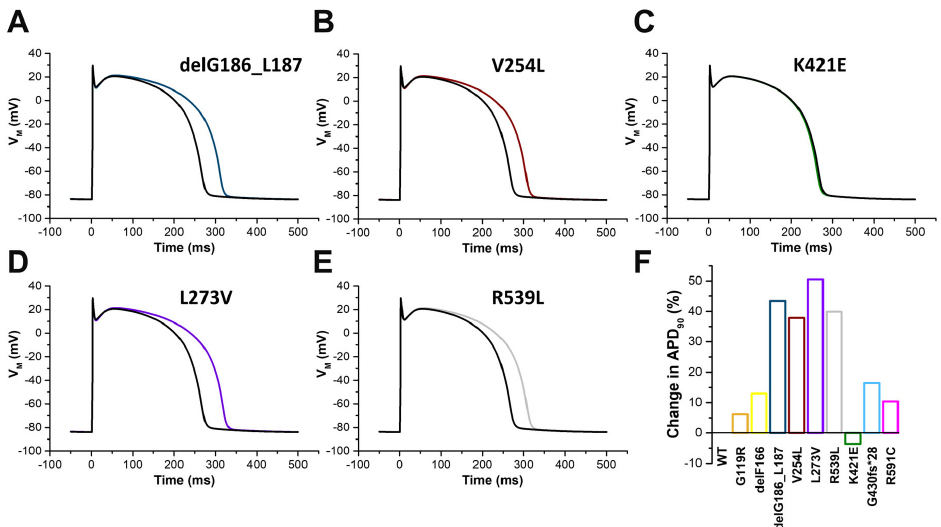
Figure 8. In silico modelling of the human ventricular action potential (AP) using the ten Tusscher modelling of human ventricular myocytes for the different KCNQ1 variants. Illustrated are the calcu- lated Aps for control (black) and ( A ) delG186 (blue), ( B ) V254L (red), ( C ) K421E (green), ( D ) L273V (blue), and ( E ) R539L (gray). ( F ) Changes in the calculated APD 90 compared to wild-type are plotted for the different KCNQ1